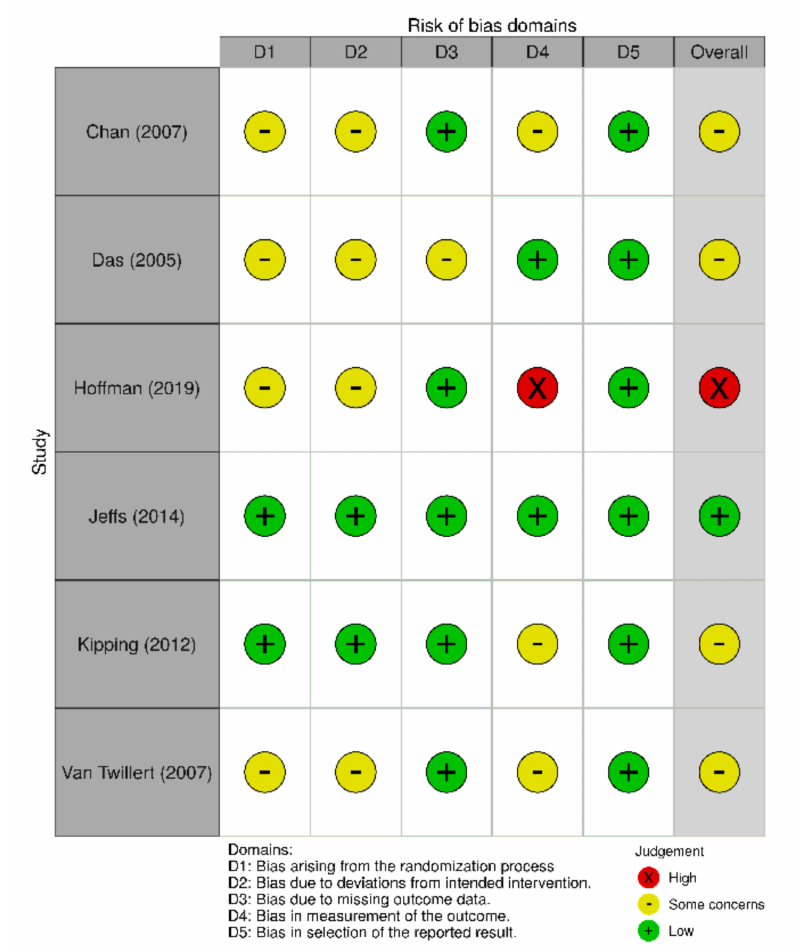
Figure A2. Risk of bias tra ffi c light plot: review authors’ judgements about each risk of bias item presented as percentages across all included RCT